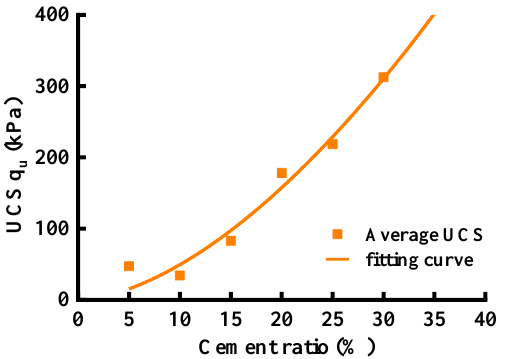
Figure 11. Relationship between the UCS of the solidified soil and the cement content.